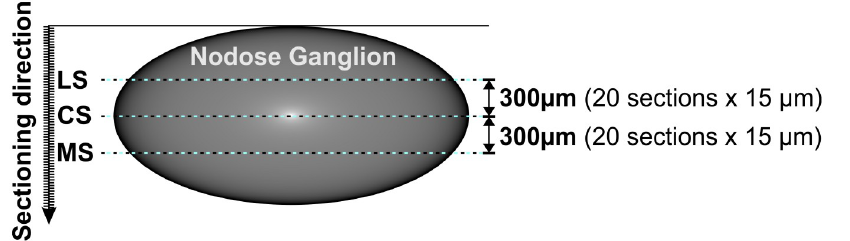
Fig 1. Tissue sampling. Drawing presenting the method of tissue sampling. Nodose ganglion tissue was cut (along its long axis) into consecutive 15 μ m sections and placed on numbered microscopic slides (four sections for each slide). The slide with a center section (CS) was determined from the total number of consecutive slides obtained from a ganglion by establishing its median. Two slides with sections distanced about 300 μ m from central section (CS) were then determined by counting 20 consecutive sections (each section thickness = 15 μ m; 4 sections on slide = 5 slides) in both directions (LS-lateral section; MS-medial section). This procedure guaranteed the collection of tissues from the same localizations in each ganglion (regardless of some individual differences in the size of the ganglia studied) and prevented the double counting of the same